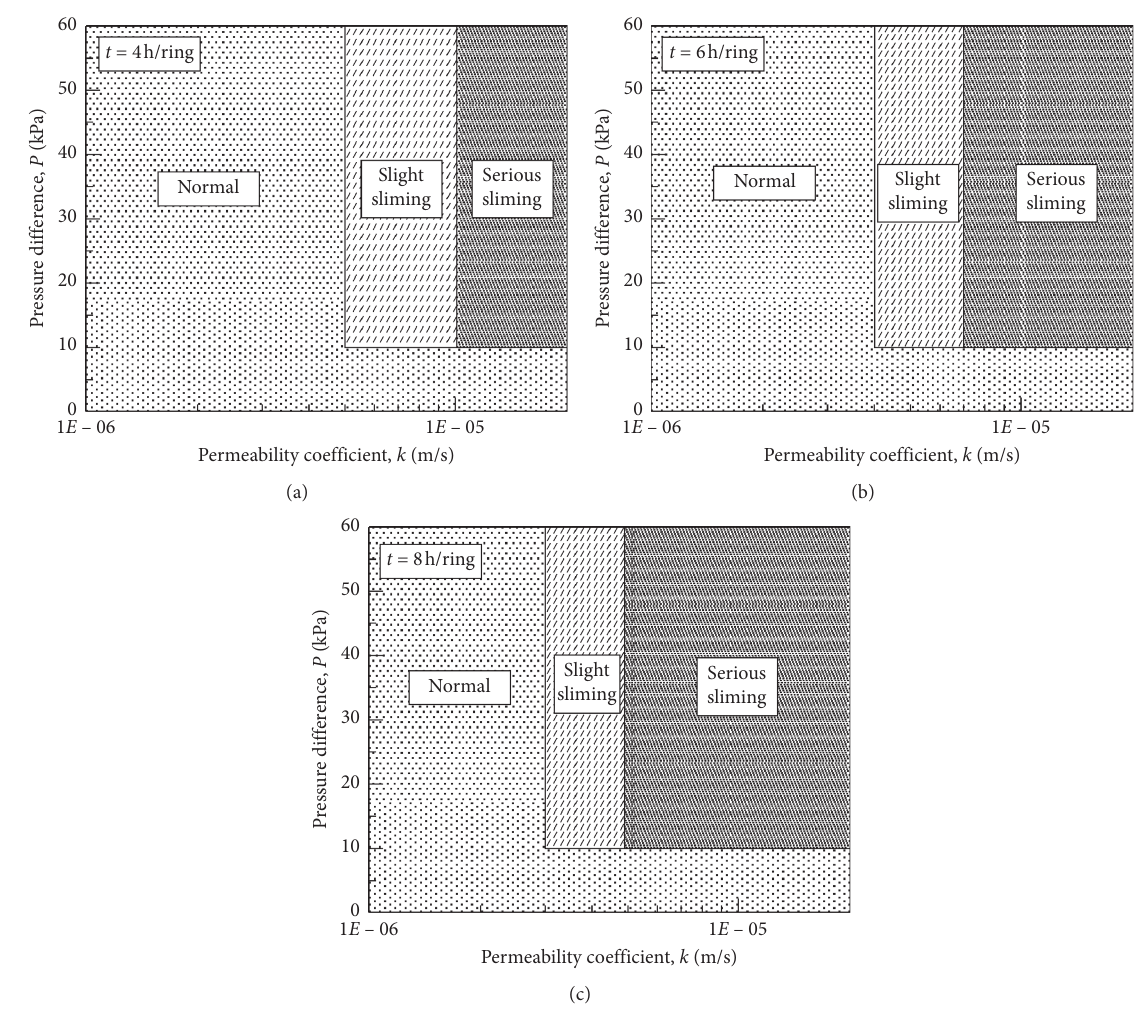
Figure 15: Critical condition of the sliming phenomenon of chamber